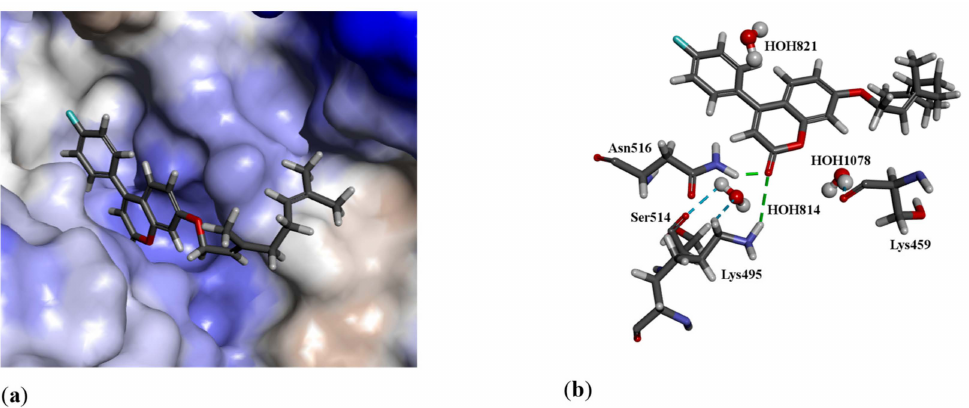
Figure 7. The docked configuration of 3ba in the binding site of Tdp1 as predicted using the ChemPLP scoring function. ( a ) The protein surface is rendered. The ligand occupies the binding pocket. Blue depicts a hydrophilic region with a partial positive charge on the surface; brown depicts hydrophobic region with a partial negative charge and grey shows neutral areas. ( b ) Hydrogen bonds are shown as green lines between the ligand and residues Lys495 and Asn516. The water molecules also form hydrogen bonds with Ser514 and